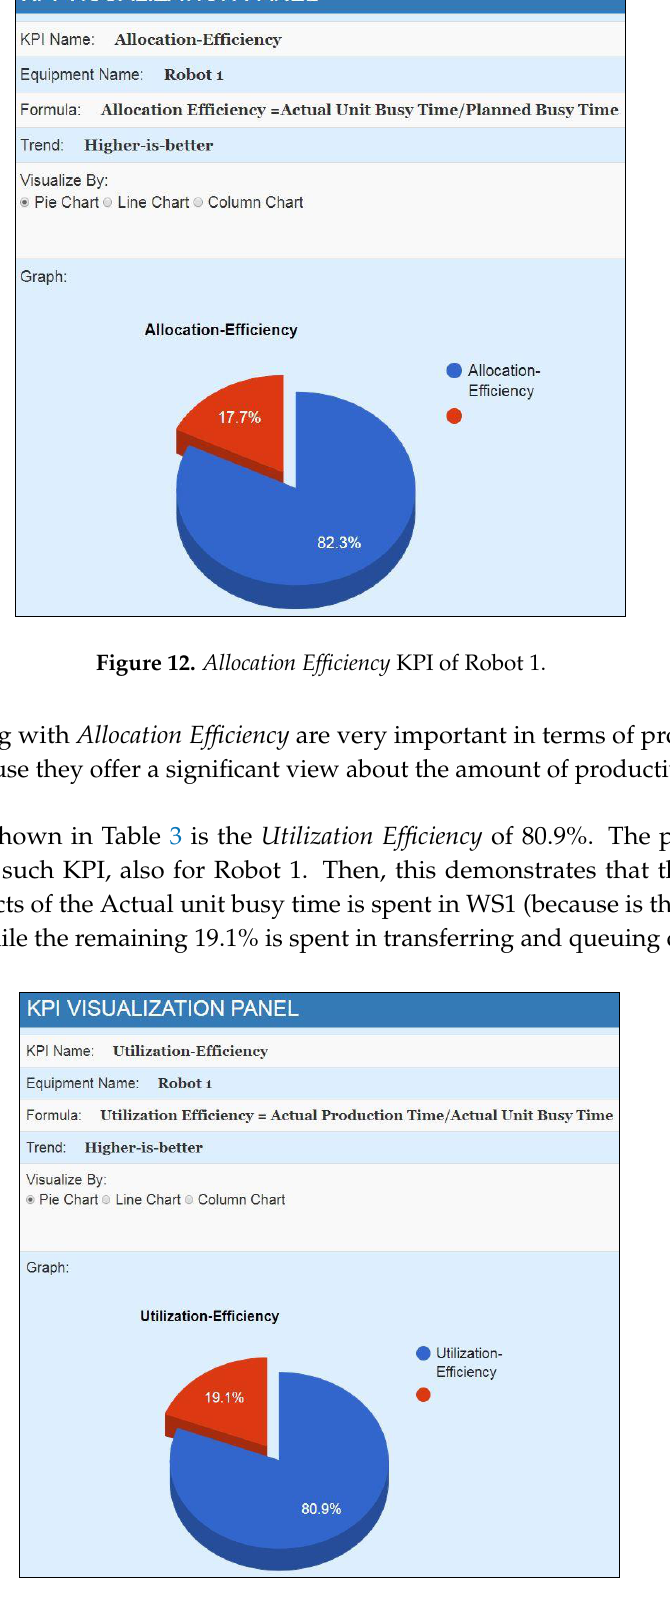
Figure 13. Utilization Efficiency KPI of Robot 1.